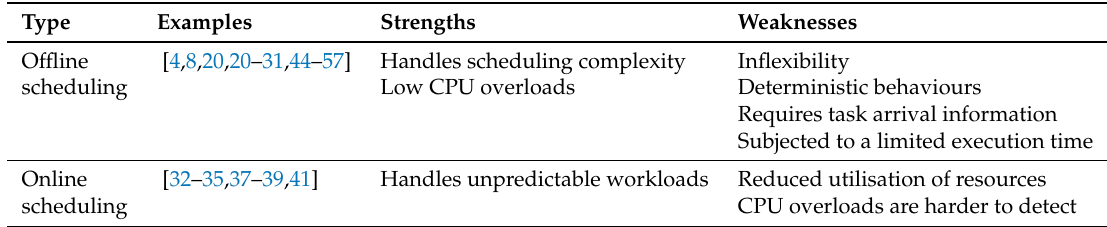
Table 1. A summary of the related literature